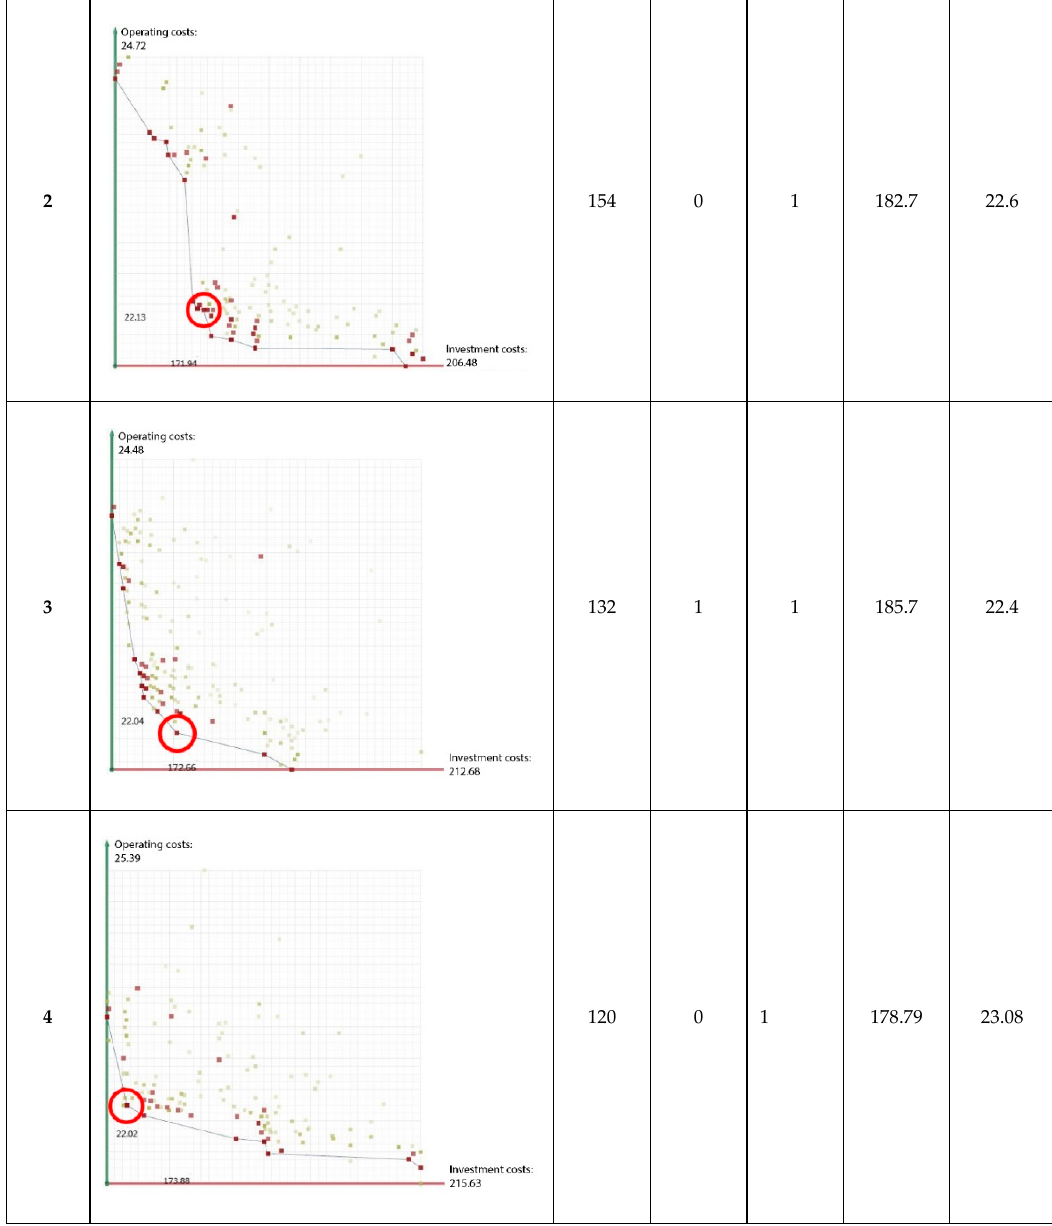
Figure 14. Economic-energy optimisation. Chosen solutions for each of established groups. Variable A—glazing width 0.8–2.0 m; Variable B—glazing type; Variable C—wall type; F 1 invest—investment costs; F 2 usable—exploitation costs.